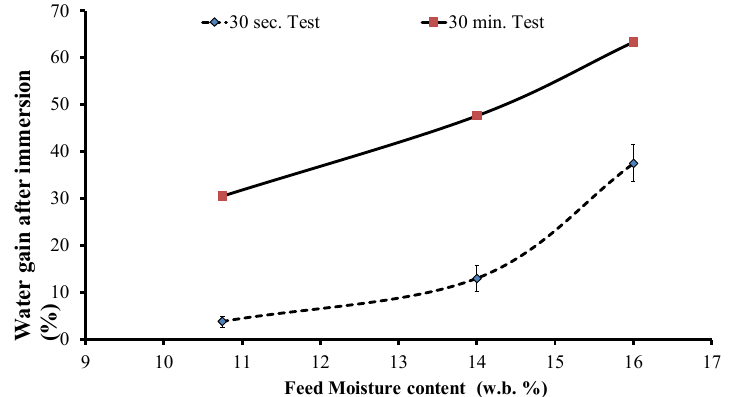
Figure 12. Water immersion results. *MC: Moisture content. Figure 13. After 24 h of water immersion: ( 1 ) 10.75% moisture, ( 2 ) 16% moisture. 3.4. Durability Mechanical durability is one of the significant parameters from the viewpoint of handling and transportation when utilizing existing coal infrastructure. The durability index results of each sample are shown in Table 3. The highest durability index was found for the HTM-LTM mix sample with a 10% to 11% moisture content. At this moisture content, the briquettes showed fewer cracks and enhanced overall binding (i.e., mechanical binding) along with binding promoted by the inherent lignin. The increase in durability for this HTM-LTM mix compared to the LTM materials might be